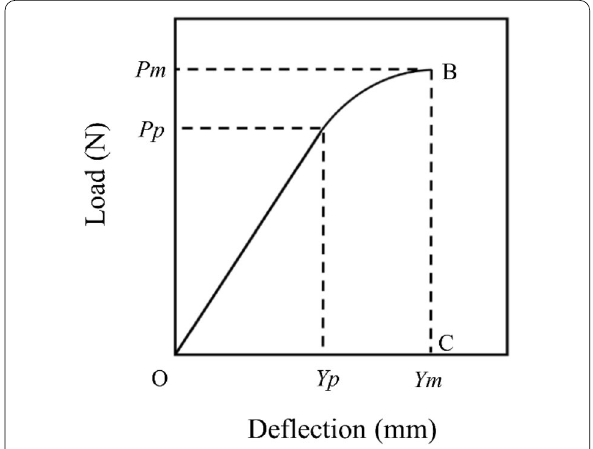
Fig. 1 Calculation of static bending properties from load–deflection curve of static bending test [10]. Pm , maximum load; Pp , load at proportional limit; Ym , maximum deflection; Yp , deflection at proportional limit. MOE and MOR were determined by the following 3 Pml /2 bh 2 , where equations: MOE (GPa) Ppl 3 /4 Ypbh 3 , MOR (MPa) = = l is the span, b is the width of the specimen, h is the height of the specimen, bending work is an area enclosed with OBC in this